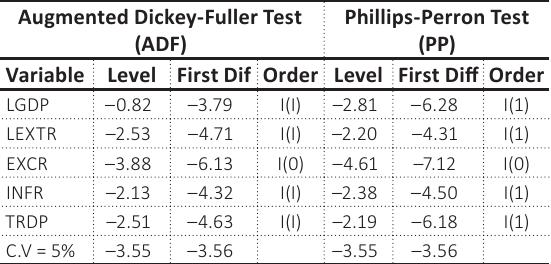
Table 2. Unit root test results